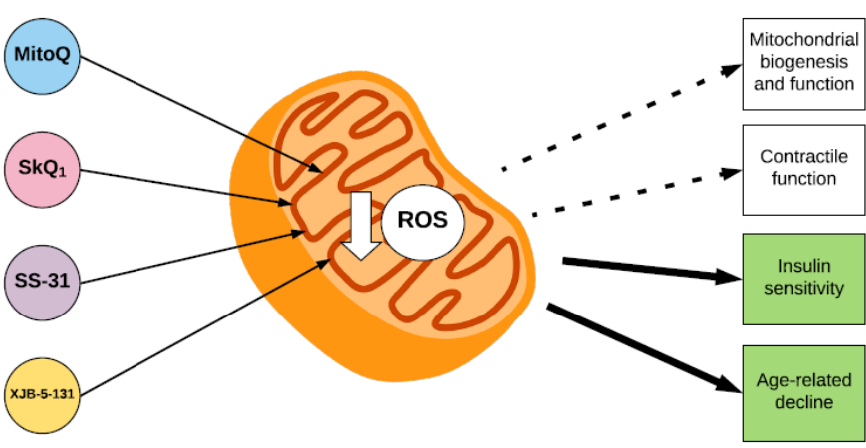
Figure 3. The effect of mitochondria-targeted antioxidants on parameters of skeletal muscle function. The mitochondria-targeted antioxidants MitoQ and SkQ1, and the mitochondria-locating peptides SS-31 and XJB-5-131 accumulate within the inner membrane of the mitochondrion, where they decrease ROS. Mitochondria-targeted antioxidants have a beneficial effect on insulin sensitivity and age-related declines in muscle function (indicated by green squares). However, their effects on mitochondrial biogenesis and function and skeletal muscle contractile function are still unclear (indicated by white squares).